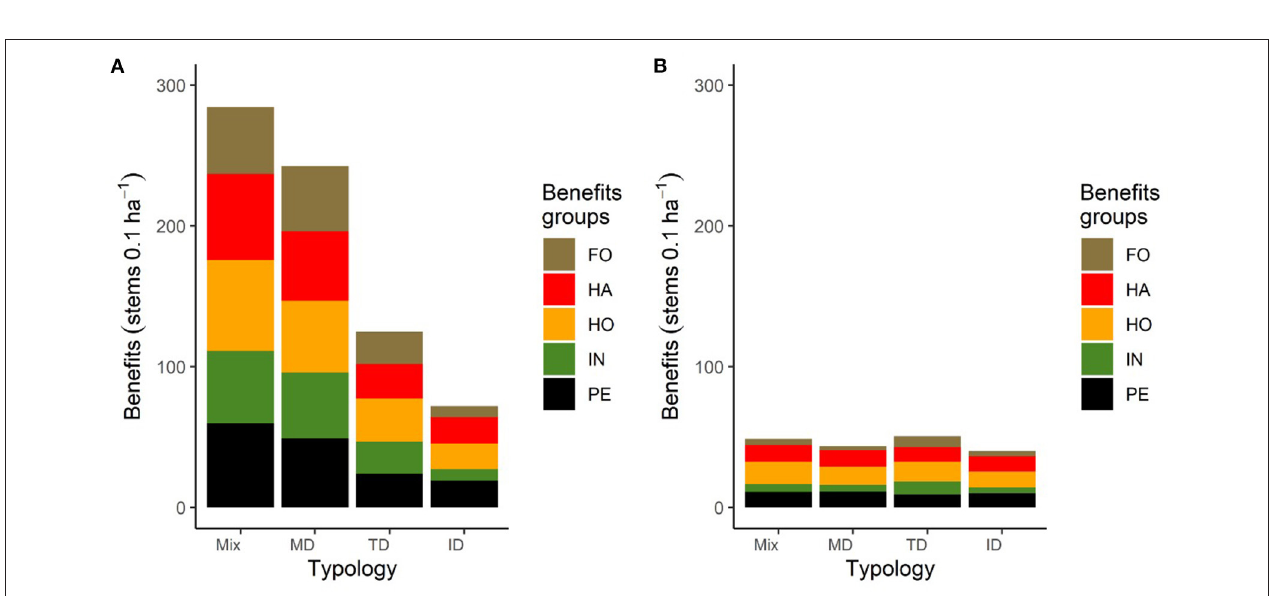
FIGURE 3 | Benefits composition from the agroforestry system in 140 plots displayed by typology. FO, Food; HA, Habitat; HO, Other household use; IN, Income; PE, Productivity enhancement coffee.